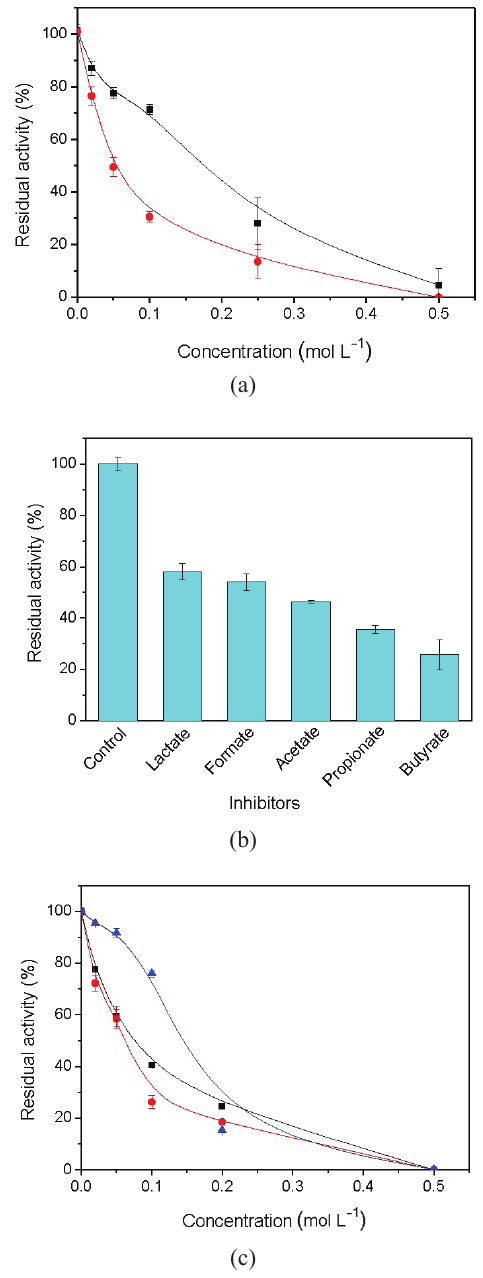
Fig. 2 – Enzyme activity in the presence of inhibitors. (a) In- fluence of sodium acetate (square) and sodium bicarbonate (circle) on the activity of free CCA; (b)Influence of 50 mmol L –1 lactate, formate, acetate, propionate, and butyrate on enzyme activity; and (c) Influence of pyridine (triangle), glucosamine (square) and ethanolamine (circle) on the activity of free